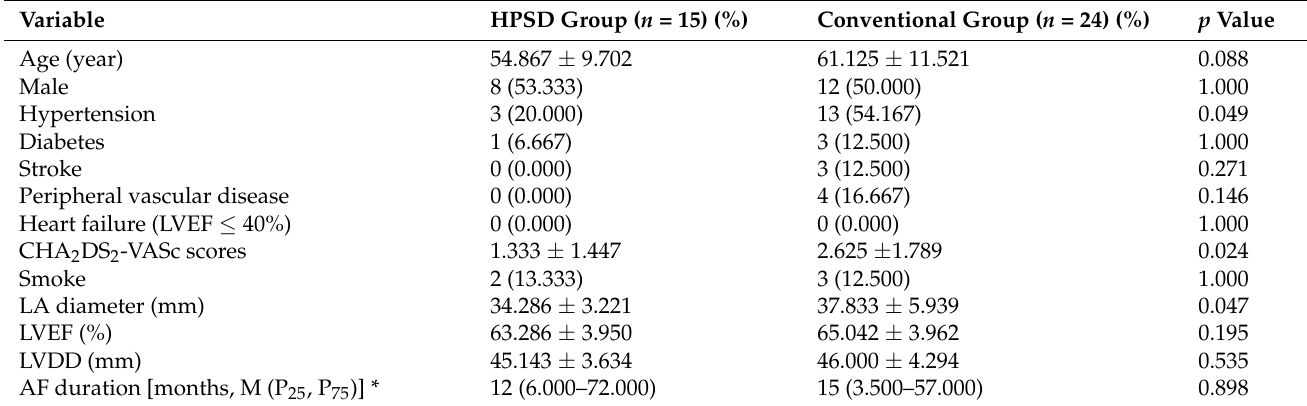
Table 5. Baseline characteristics of patients undergoing repeat